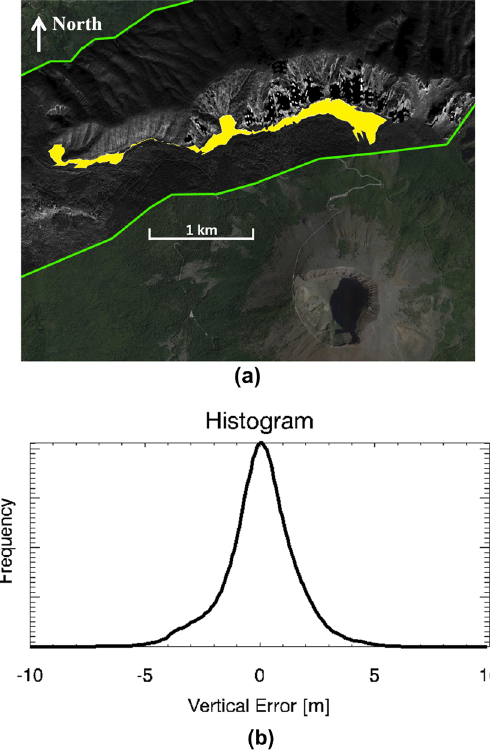
Figure 6. ( a ) Zoom of the frame 2 of Figure 3a. The lava flow erupted from the Somma Vesuvio volcanic complex in 1944 covered by the laser scanner DEM is highlighted in yellow; ( b ) Histogram of the vertical difference between the InSAeS4 DEM and the laser scanner DEM in the yellow area of Figure 6a.